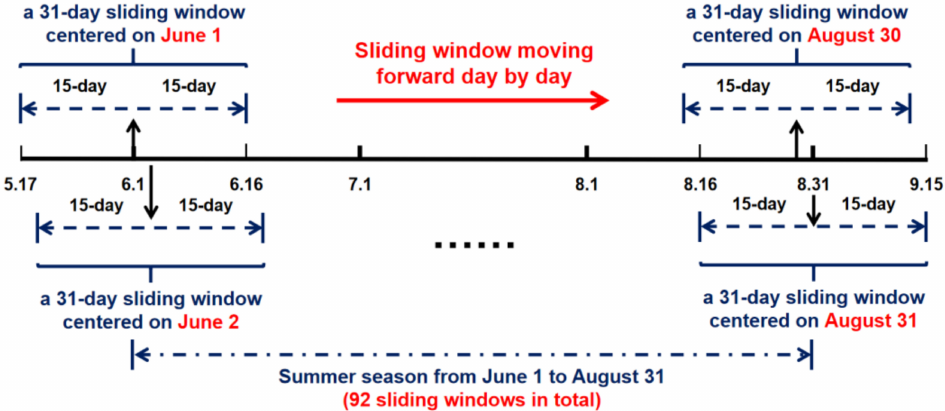
Figure 3. Schematic diagram of using the new method to determine the diurnal threshold for each of the days during the summer season.